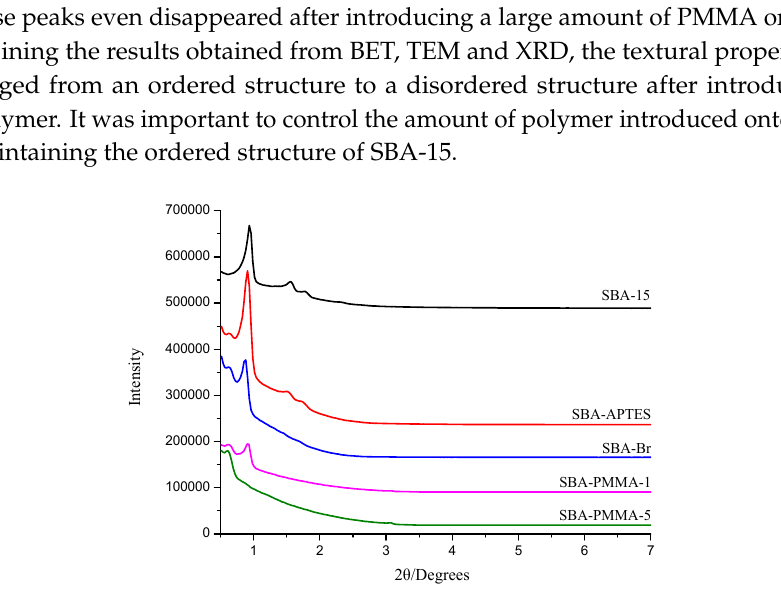
Figure 6. The small and large angles of powder XRD patterns of SBA-15, SBA-APTES, SBA-Br, SBA-PMMA-1 and SBA-PMMA-5.